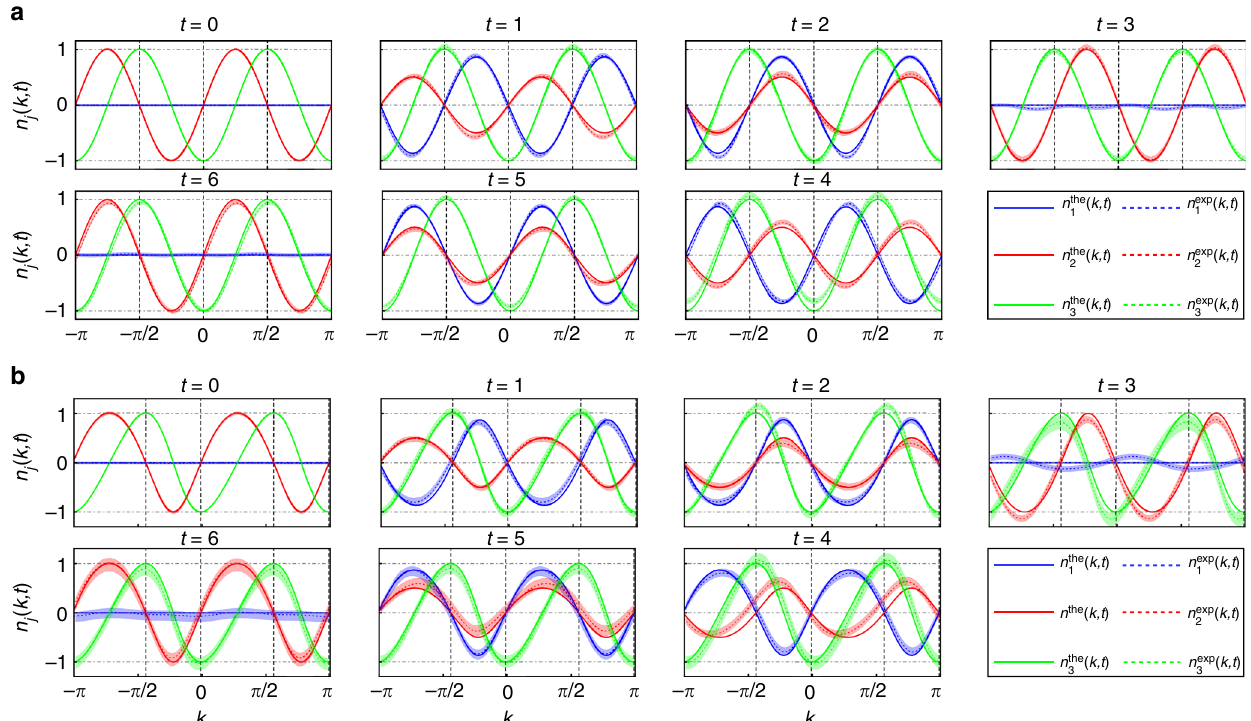
Fig. 3 Experimental results of n ( k , t ). Time-evolution of n ( k , t ) up to t = 6 for quench processes between ( a ) an initial unitary Floquet operator ¼ π = 4 ; θ i ¼ (cid:3) π = 2 Þ and a fi nal unitary Floquet operator characterized by ð θ f characterized by ð θ i 1 2 ¼ π = 4 ; θ i ¼ (cid:3) π = 2 Þ and a fi nal non-unitary Floquet operator characterized by θ f operator characterized by ð θ i 1 2 of oscillations is t 0 = 6 for all k . Fixed points (vertical dashed lines) are located at { − π , − π /2, 0, π /2} for unitary dynamics ( a ) and at { − 0.4399 π , − 0.0099 π , 0.5601 π , 0.9901 π } for non-unitary dynamics ( b ). Shading indicates experimental error bars that are due to photon-counting